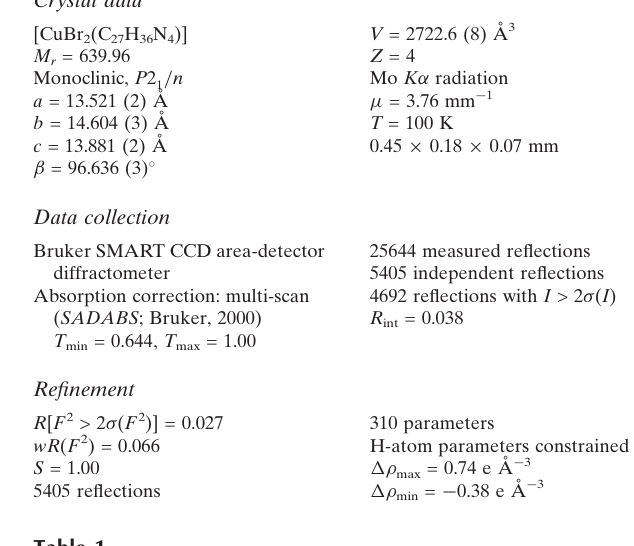
Selected geometric parameters (A˚ , (cid:3) ).